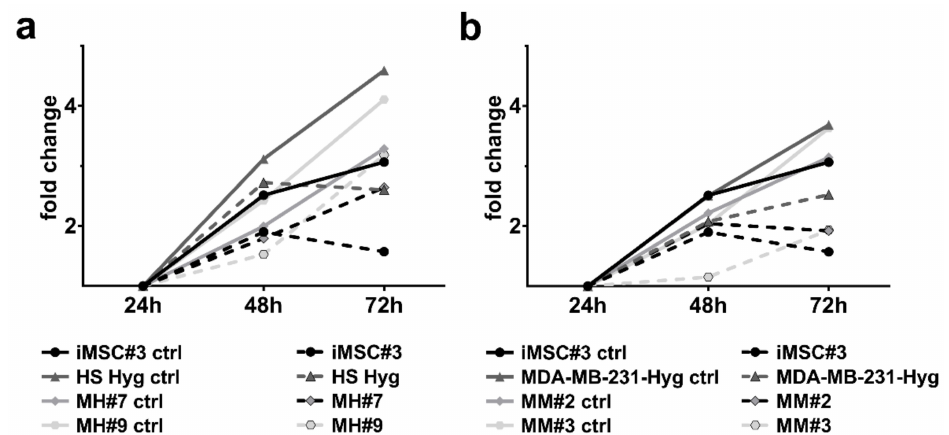
Figure 7. Summary of cytotoxicity test results for ( a ) iMSC#3, HS578T Hyg, MH#7, and MH#9 cells and ( b ) iMSC#3, MDA-MB-231 Hyg, MM#2 and MM#3 cells, which were treated with 0.1 µ M